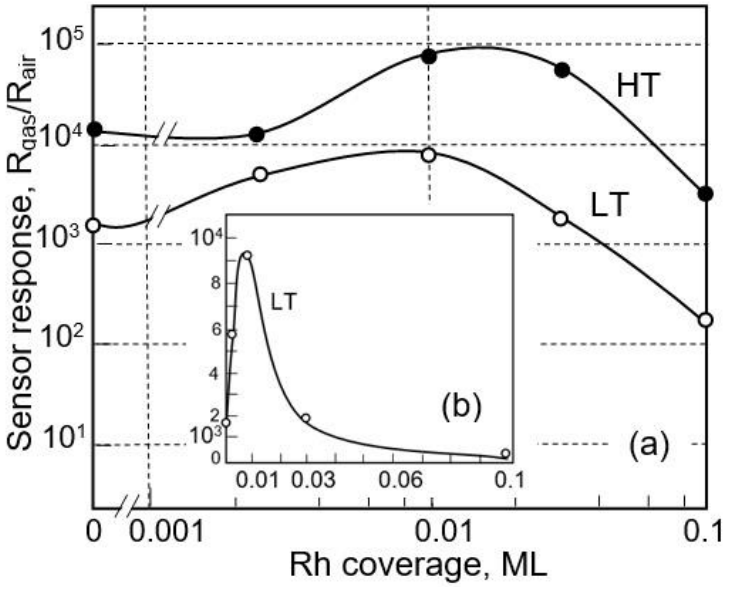
Figure 1. Effect of surface modification of LT and HT In 2 O 3 films with rhodium on their conductometric response to ozone (~1 ppm): data are presented on ( a ) logarithmic and ( b ) linear scales ( T oper = 250 °C).